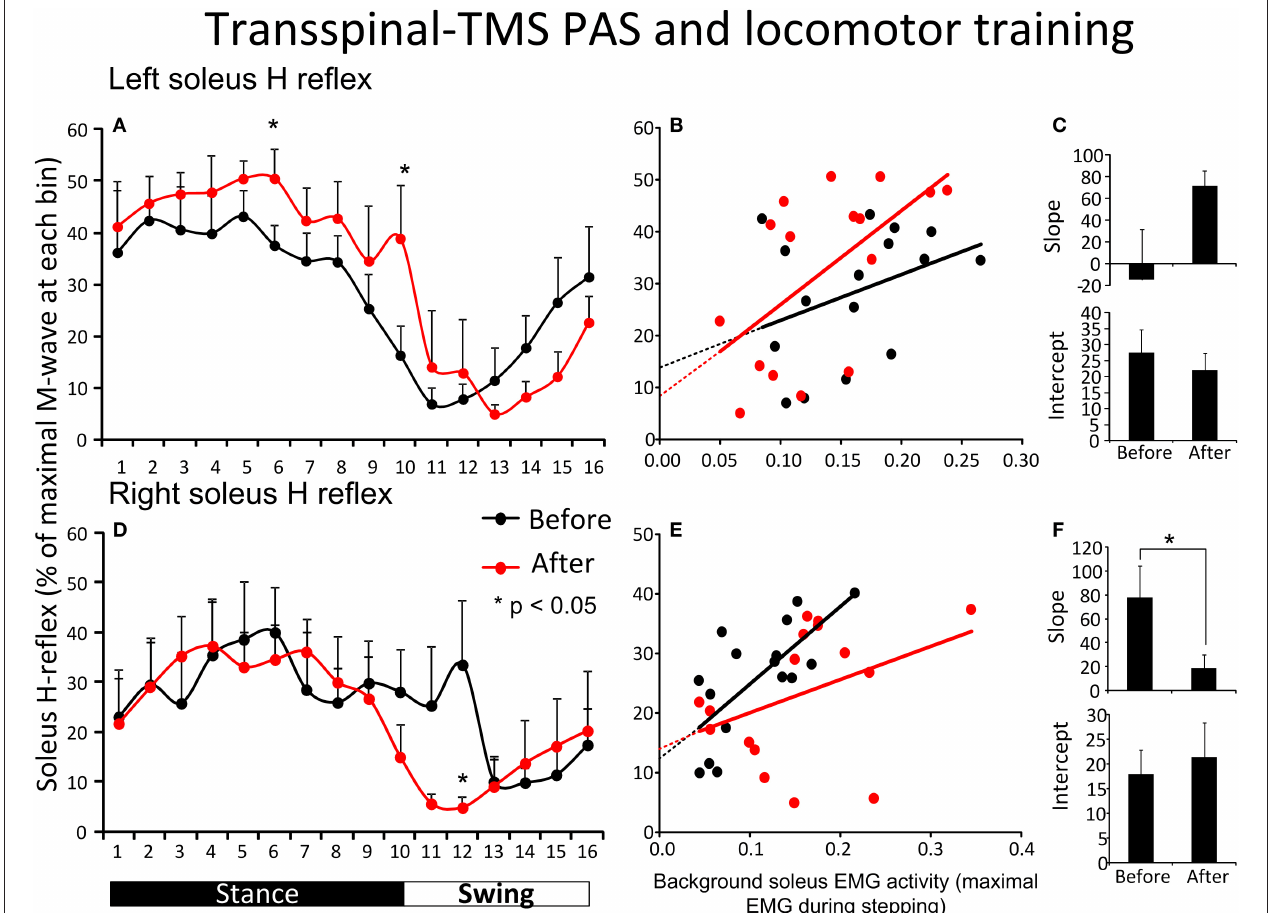
FIGURE 3 | Soleus H-reflex modulation during assisted stepping before and after transspinal-TMS PAS and locomotor training. The mean soleus H-reflex amplitude recorded from the left and right legs (A,D) before (black lines) and after (red lines) transspinal-TMS PAS and locomotor training, along with the soleus H-reflex amplitude plotted against the soleus EMG background activity (B,E) . The 16 points in graphs (B,E) correspond to the 16 bins of the step cycle. The overall amplitude of the slope and intercept for the left (C) and right (F) legs resulting from the linear relationship between the mean amplitude of the soleus H-reflex and EMG background. EMG, electromyogram; PAS, paired associative stimulation; TMS, transcranial magnetic stimulation. Error bars indicate the SEM. * p < 0.05.